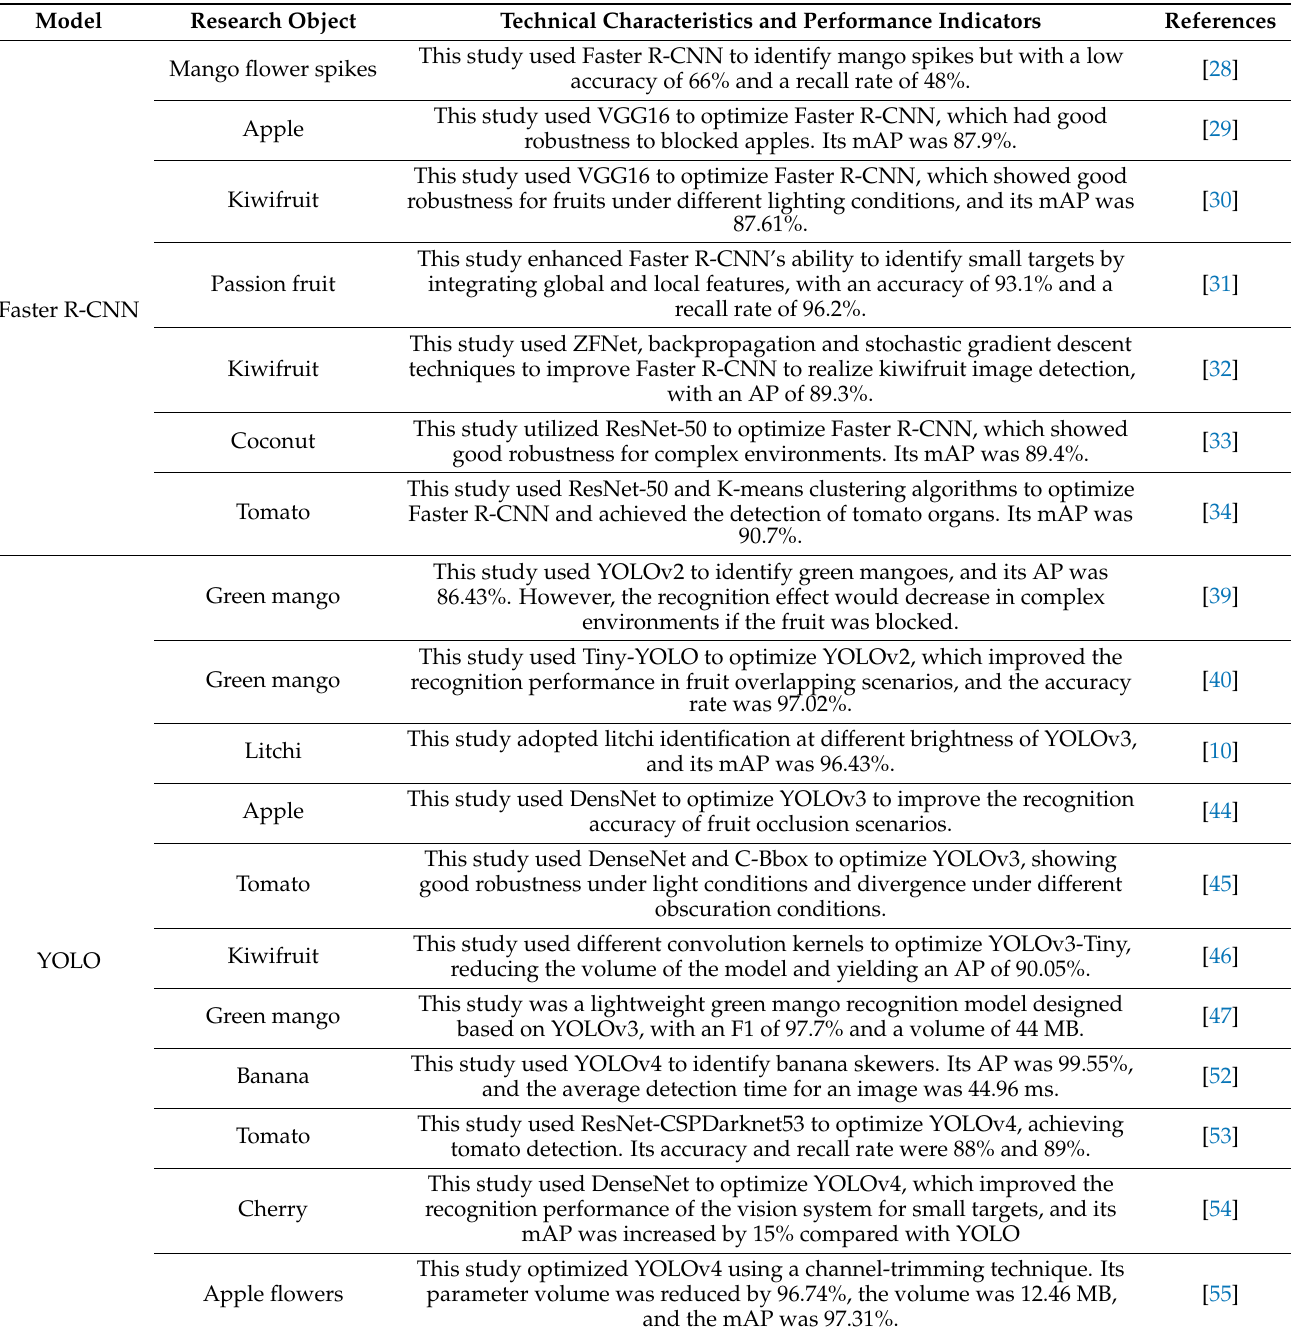
Table 2. Comparison of research results of deep-learning-based target detection methods. Technical Characteristics and Performance